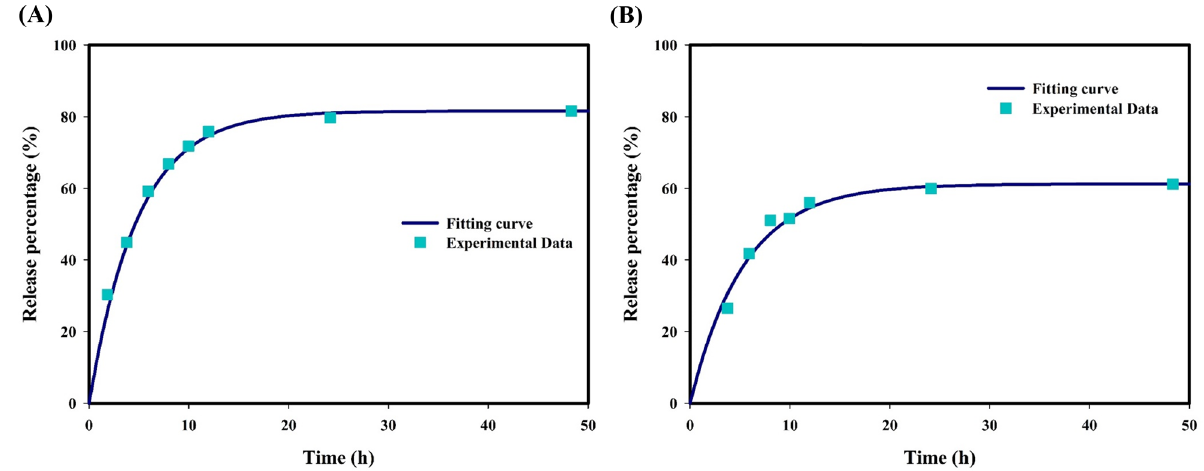
Figure 6. Drug release at ( A ) pH = 6.2; and ( B ) pH = 7.2. Experimental data extracted from the literature 38